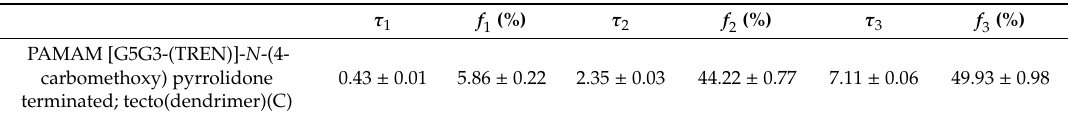
Table 1. Fluorescence lifetimes ( τ ) and intensity fractions ( f ) or respective fluorescence decay curve components of PAMAM [G5:G3-(TREN)]- N -(4-carbomethoxy) pyrrolidone terminated tecto(dendrimer) (C) (pH 7.4). Values are shown as average ± s.e.m. ( n = 4). 𝝉 𝟏